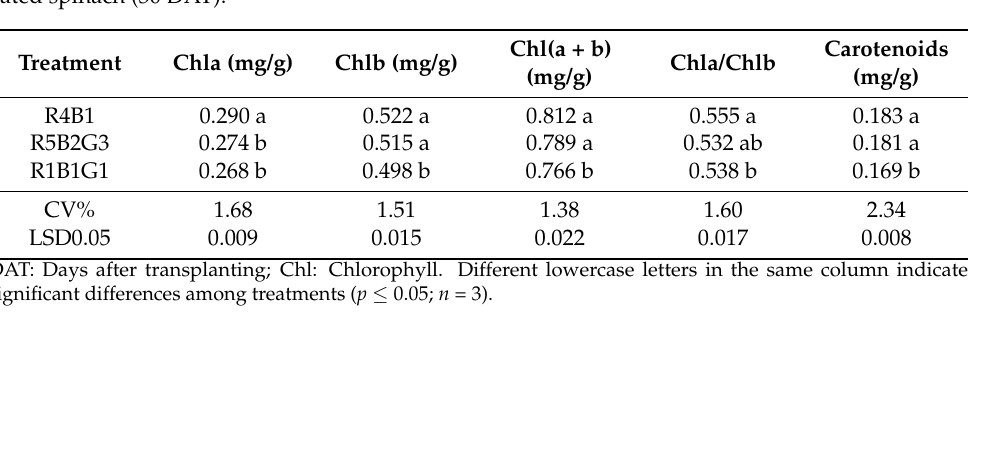
Table 2. Effects of different light qualities on the photosynthetic pigments of hydroponically culti- vated spinach (30